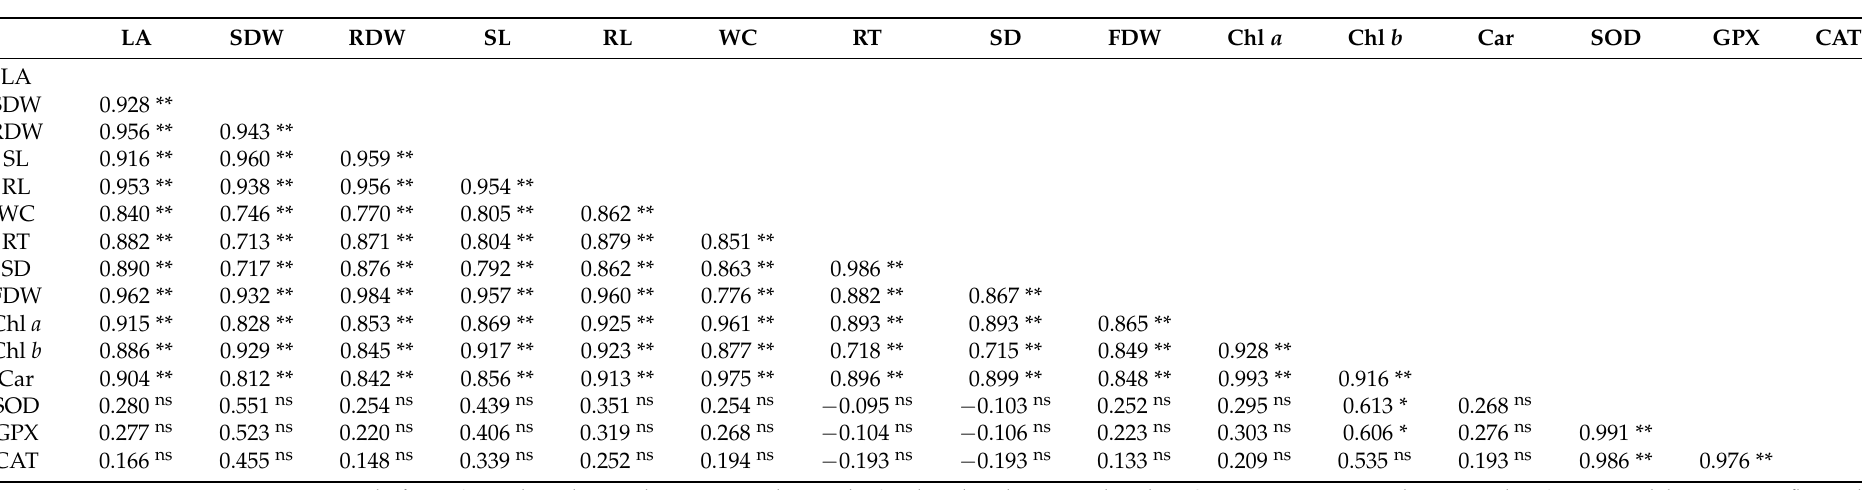
Table 3. Pearson correlation among morphological, physiological, and biochemical traits of calendula following foliar chitosan application under water stress